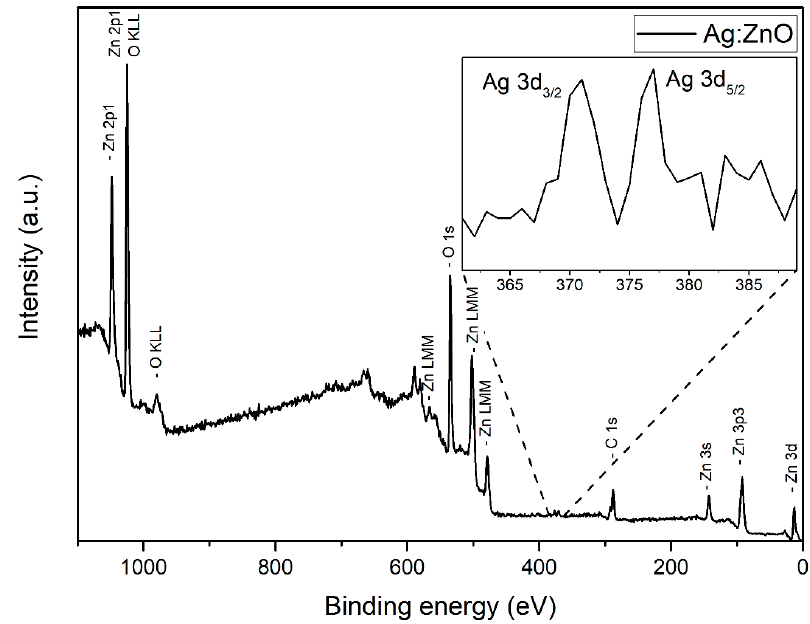
Figure 6. XPS spectrum of Ag-doped ZnO NP (3000 pulses used for Ag deposition in PLD). The XPS high-resolution spectra are shown in Figure 7 for the following peaks: (a) Zn 2p 3/2 , (b) Ag 3d, (c) O 1s, and (d) C 1s. Deconvolution of the Zn 2p 3/2 peak (Figure 7a)